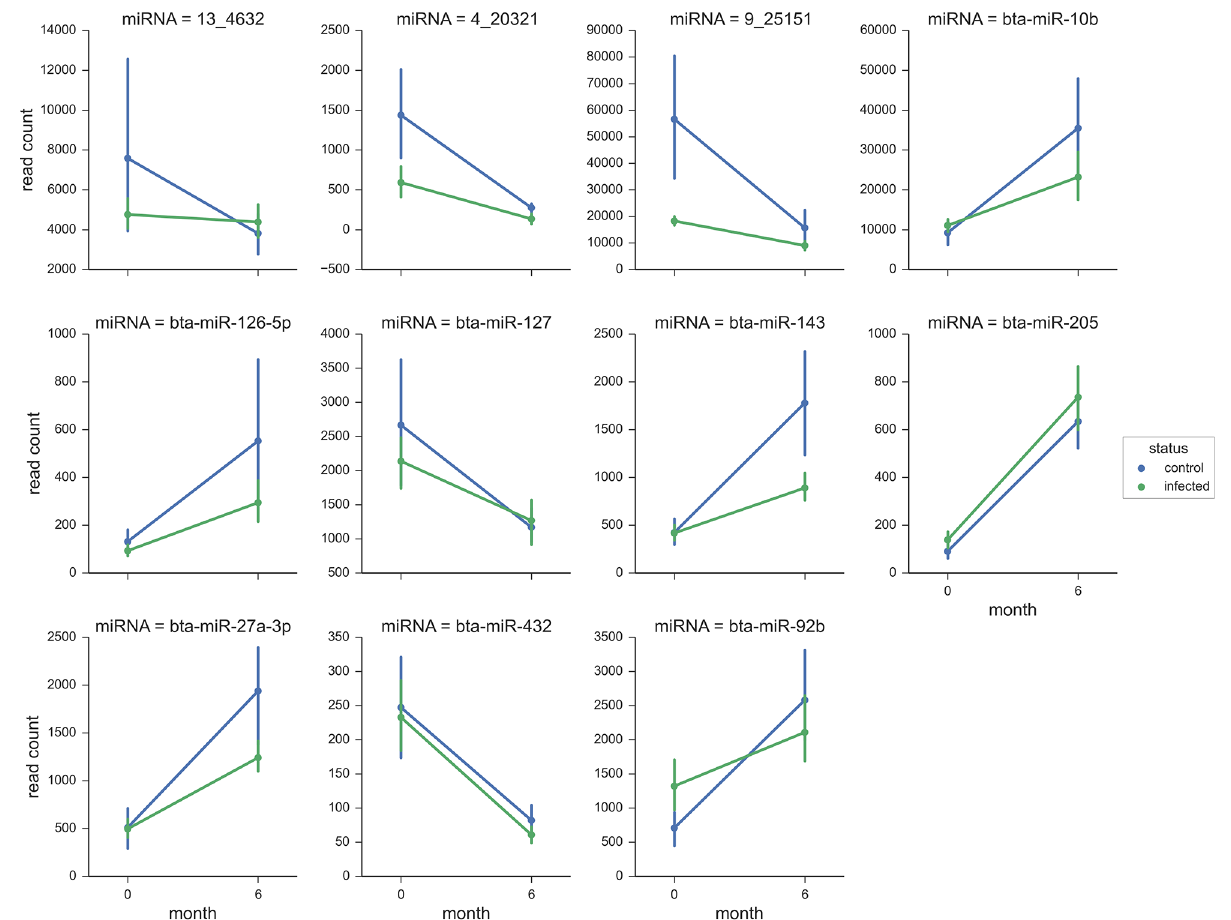
Fig 7. Differential expression results. Normalised read variation for differentially abundant genes from 0 – 6 months in both control (blue) and infected (green) groups. The bars on each point represent the within group variation for 6 animals (95% confidence interval).